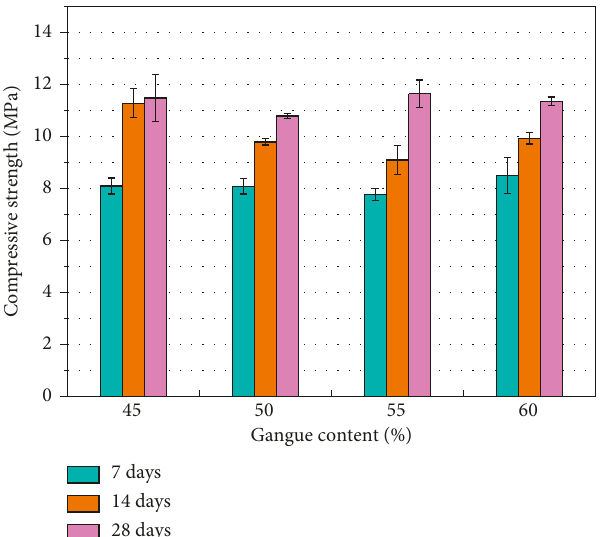
Figure 6: Concrete strengths at various ages with different